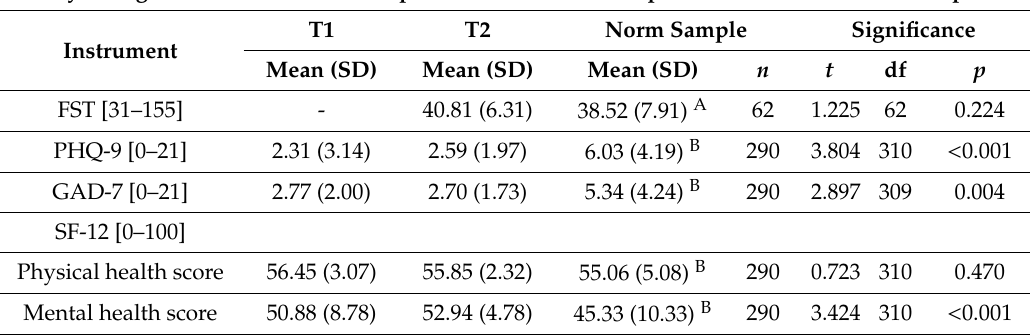
Table 3. Results from the psychometric questionnaires and group comparison with (A) volunteer medical students working in a state registration and reception center (Kindermann et al. unpublished data) and (B) first-semester medical students assessed in a previous study of Bugaj et al. [57]. Psychological Assessment—Descriptive Statistics and Comparison of T2 with Norm Sample T1 T2 Norm Sample Significance Instrument Mean (SD) Mean (SD) Mean (SD) n p